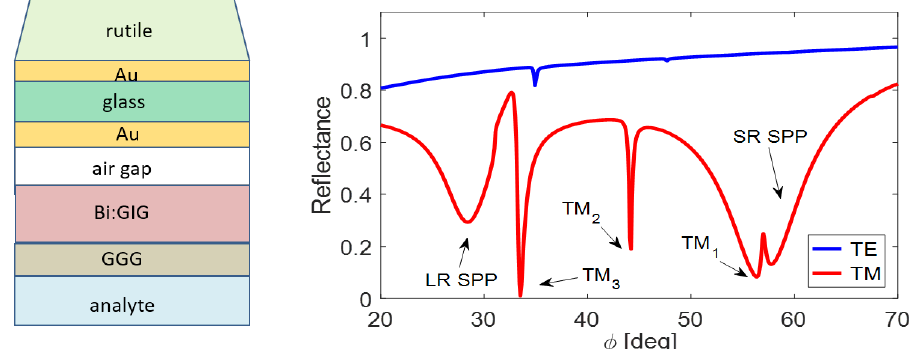
Figure 6. Reflectance response from plasmonic-waveguiding structure with marked resonance states. Finite layer thicknesses in nm (from top to bottom):